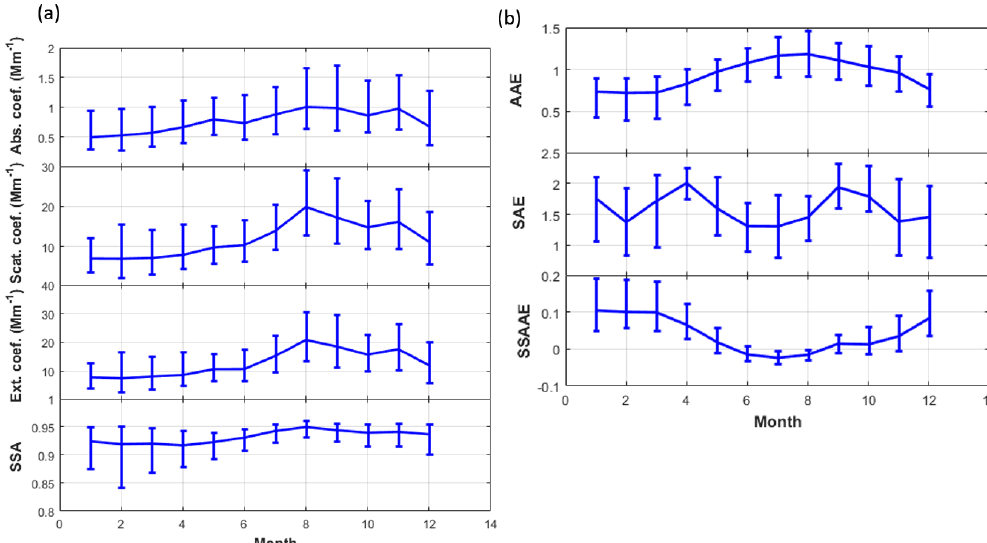
Figure 5. Monthly (a) absorption coefficient, scattering coefficient, extinction coefficient, and single scattering albedo (all at 500nm) mea- sured at the CHC station for 4 years and (b) AAE, SAE, and SSAAE. Solid line corresponds to the median, and error bars indicate the range between the 25th and 75th